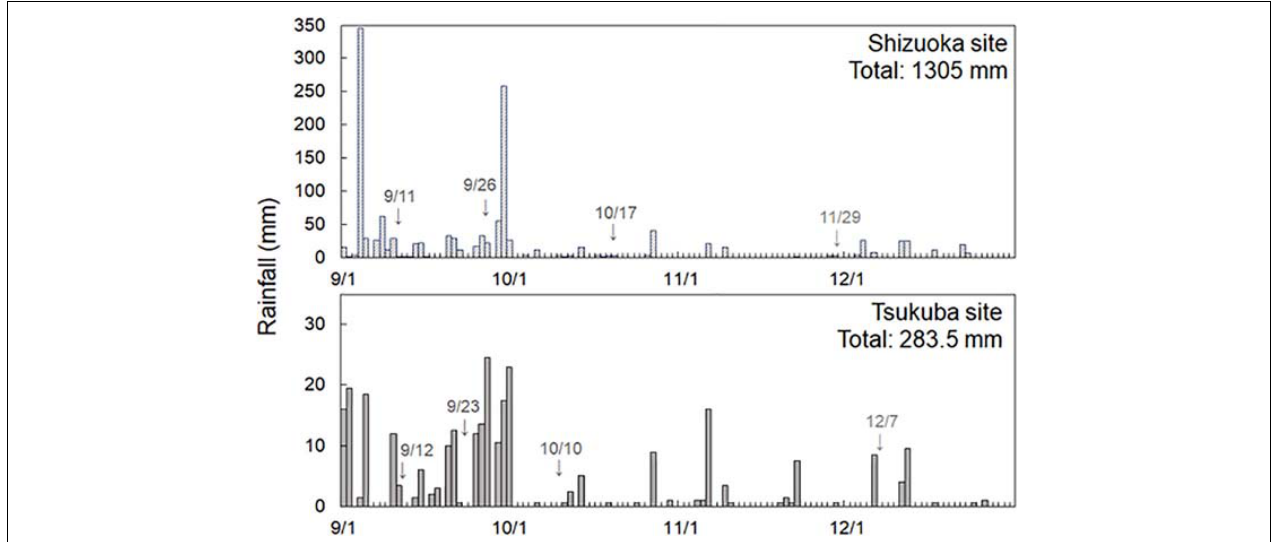
FIGURE 2 | Rainfall and sampling date from 1 September to 31 December 2018 at the Shizuoka and Tsukuba sites. Rainfall data at the Shizuoka site is from the Water Information System of the Ministry of Land, Infrastructure, Transport and Tourism (http://www1.river.go.jp/cgi-bin/SrchRainData.exe?ID=105031285523 010&KIND=1&PAGE=0, last viewed 3 December 2019), and at Tsukuba site is measured by the meteorological station of the Tsukuba Experimental Forest, Mountain Science Center, University of